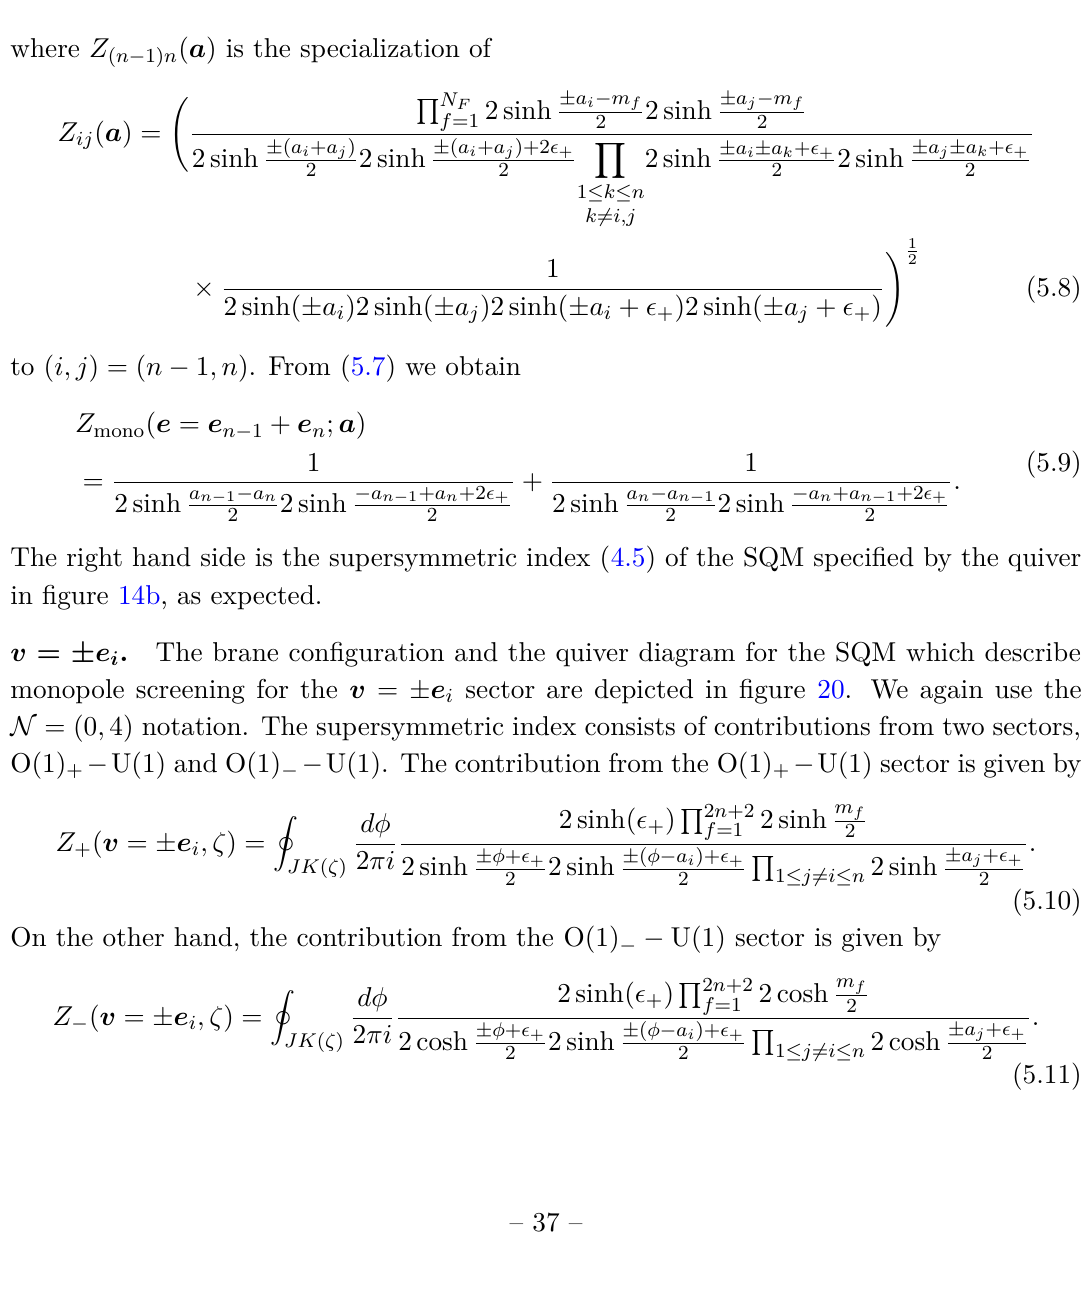
Figure 20. (a): the brane configuration for the monopole screening sector v = e N of T V · T V . (b): the corresponding SQM quiver